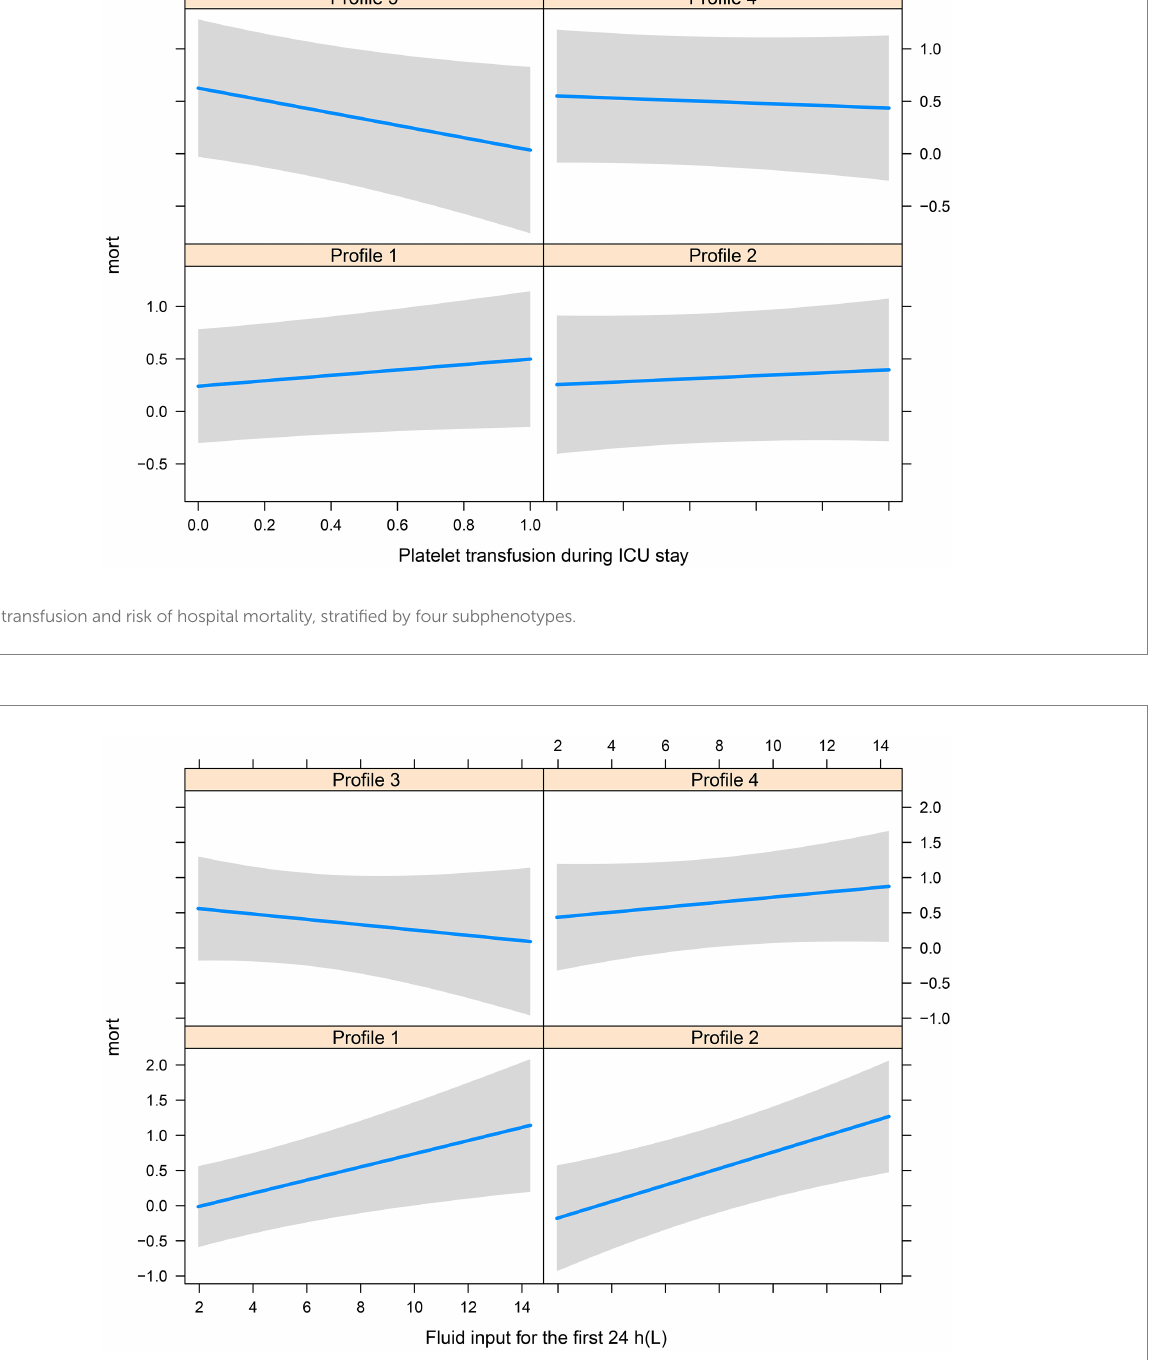
Further validation and refinement of this technique may be required to ensure its accuracy and reproducibility. Finally, we were unable to exclude patients with specific types of TP, such as TP due to pharmacological factors and immune-related TP. Fortunately, the overall proportion of such cases was small and did not affect the final results.